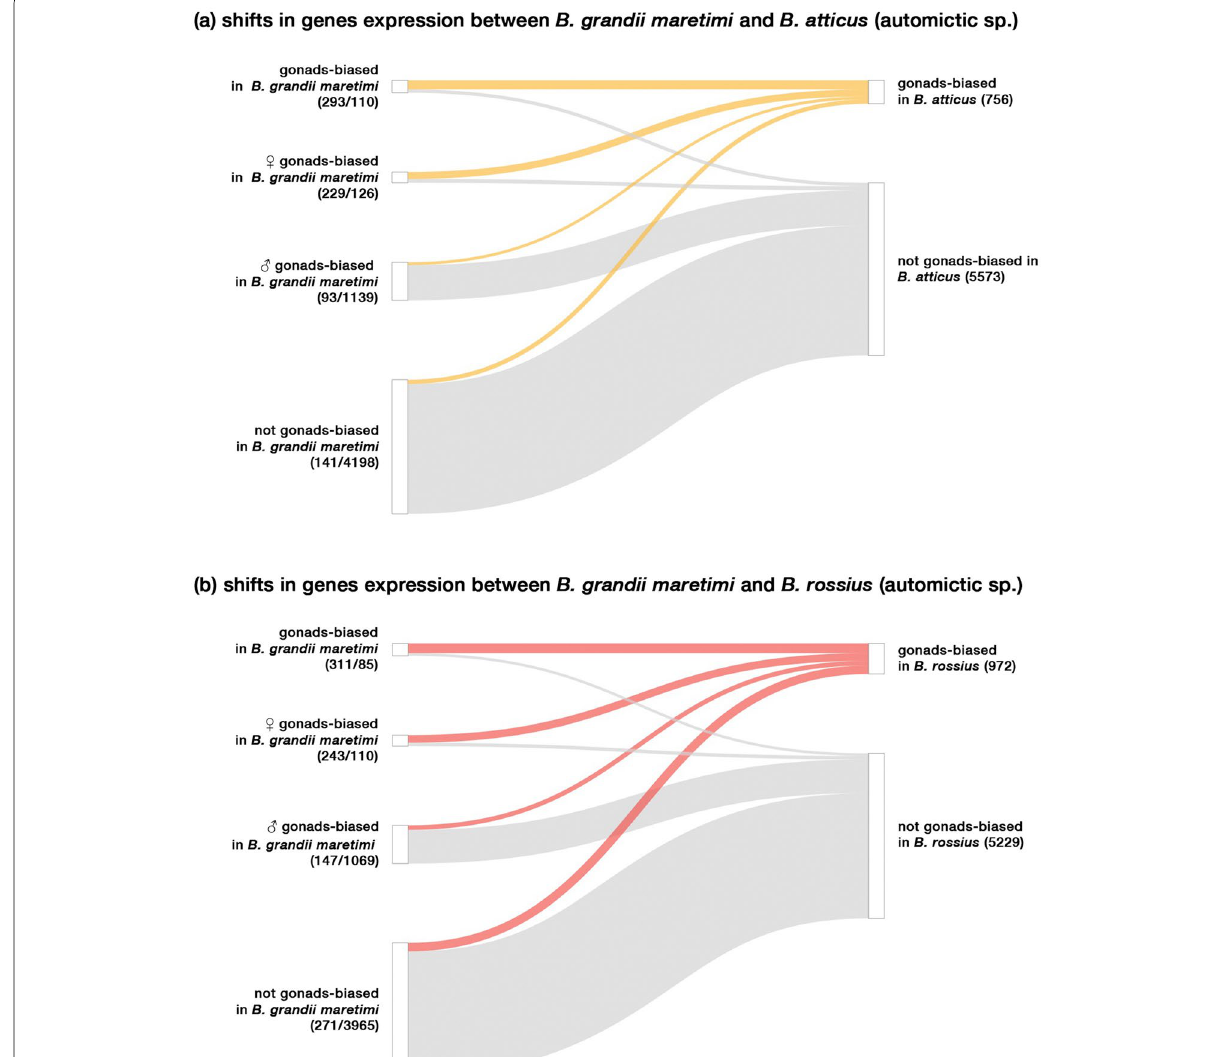
Fig. 4 Gene expression patterns of parthenogens gonads compared to the bisexual species ones: a comparison between the automictic Bacillus rossius rossius and the bisexual Bacillus grandii maretimi , b comparison between the automictic Bacillus atticus and the bisexual Bacillus grandii maretimi . Numbers in parentheses are the genes with gonads-biased or non-biased expression regulation,